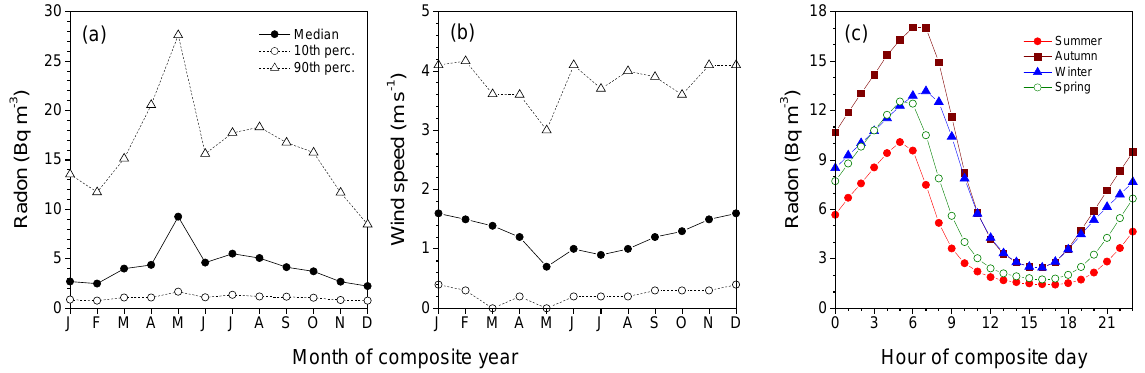
Figure 1. (a, b) Monthly distributions (10th, 50th and 90th percentiles) of radon and wind speed, (c) hourly mean diurnal composite radon by season, at